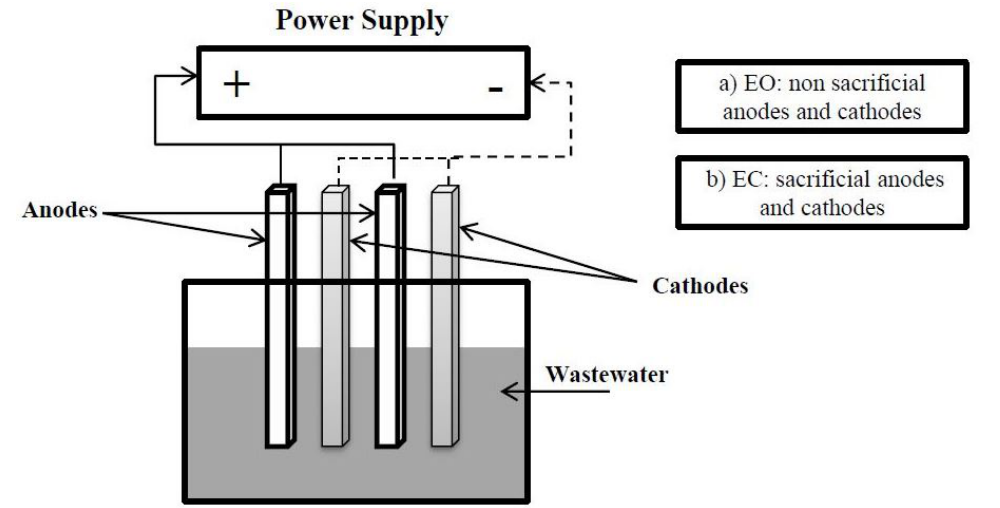
Figure 5. Electrochemical oxidation/Electrocoagulation conceptual